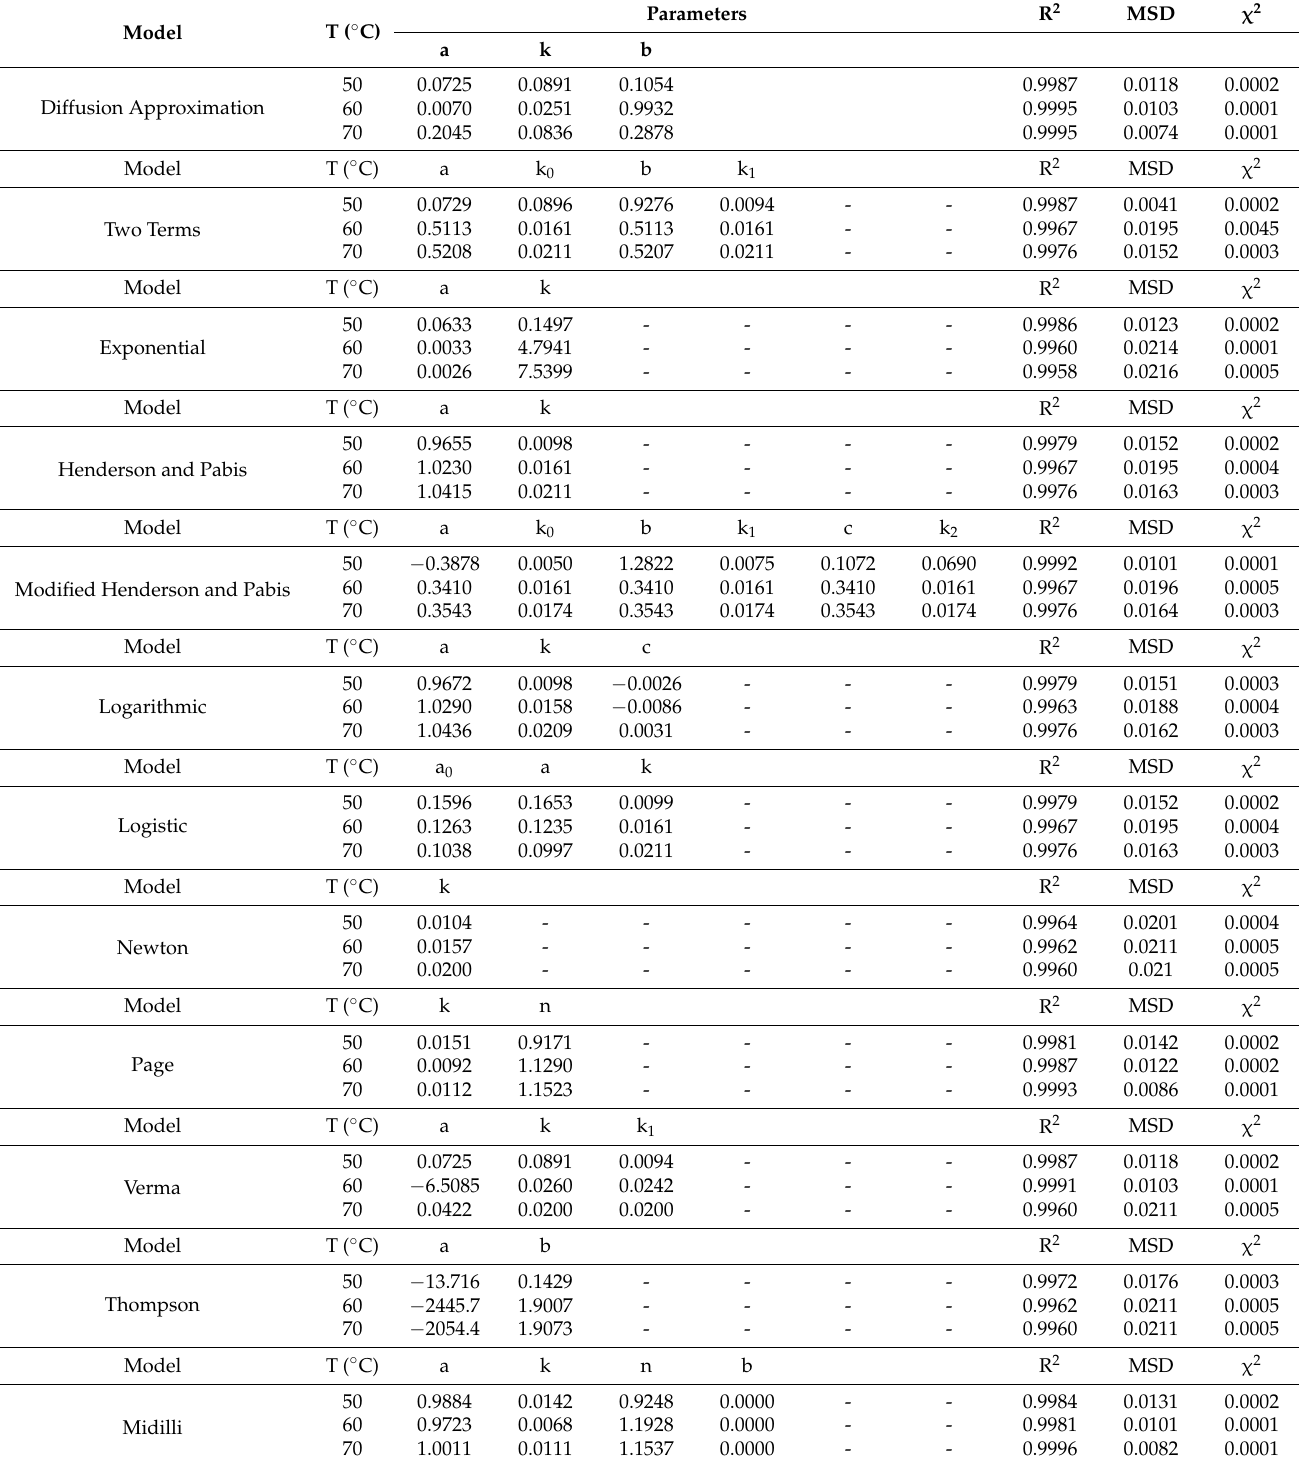
Table 4. Model parameters adjusted to drying data of pomegranate seed flour at temperatures of 50, 60, and 70 ◦